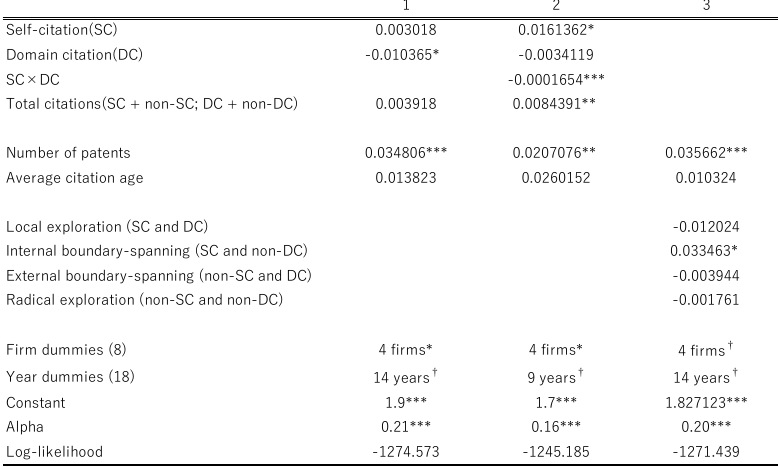
Table 7. Negative binomial regression on outside impact ( n =